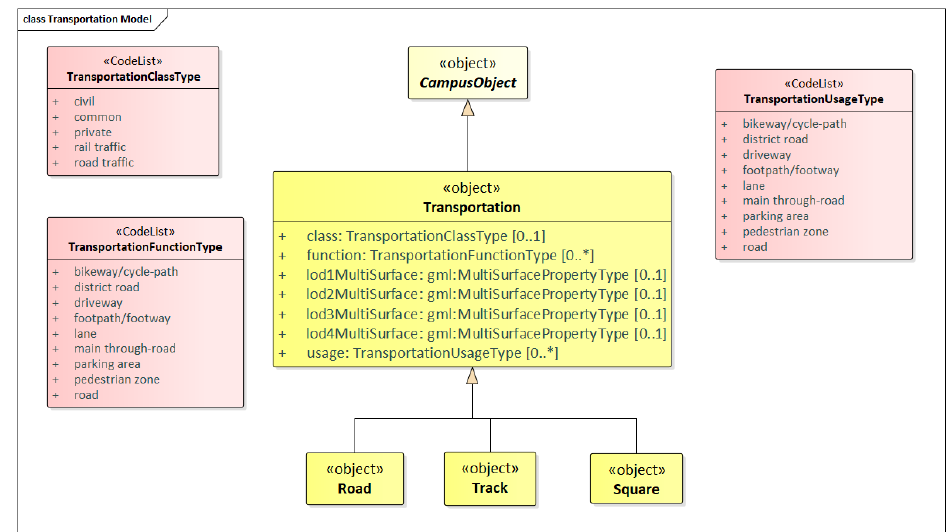
Figure 12. UML diagram of transportation model.